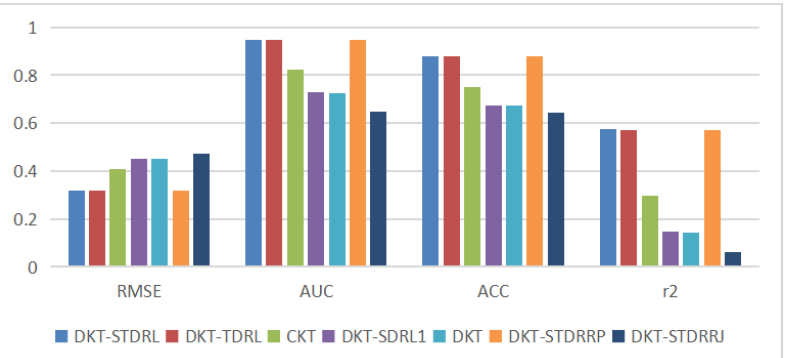
Figure 5. Prediction results of DKT-STDRL, CKT, DKT, and the variants of DKT-STDRL on the Synthetic-5 dataset.